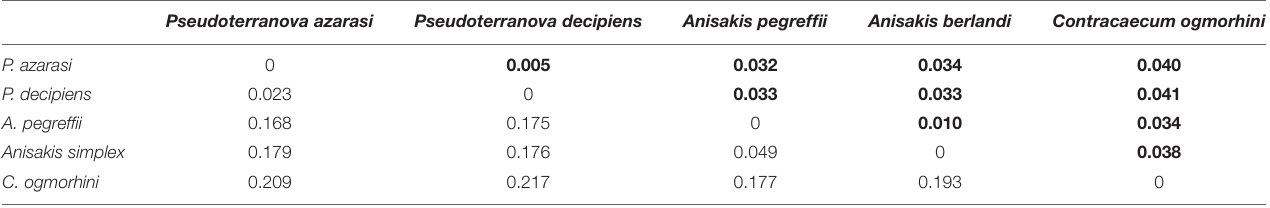
TABLE 2 | Genetic distance based on 601-bp cox2 sequence of five species from Anisakidae (bold numbers show the standard deviation, in populations with more than three sequences). Pseudoterranova azarasi Pseudoterranova decipiens Anisakis pegreffii Anisakis berlandi Contracaecum ogmorhini